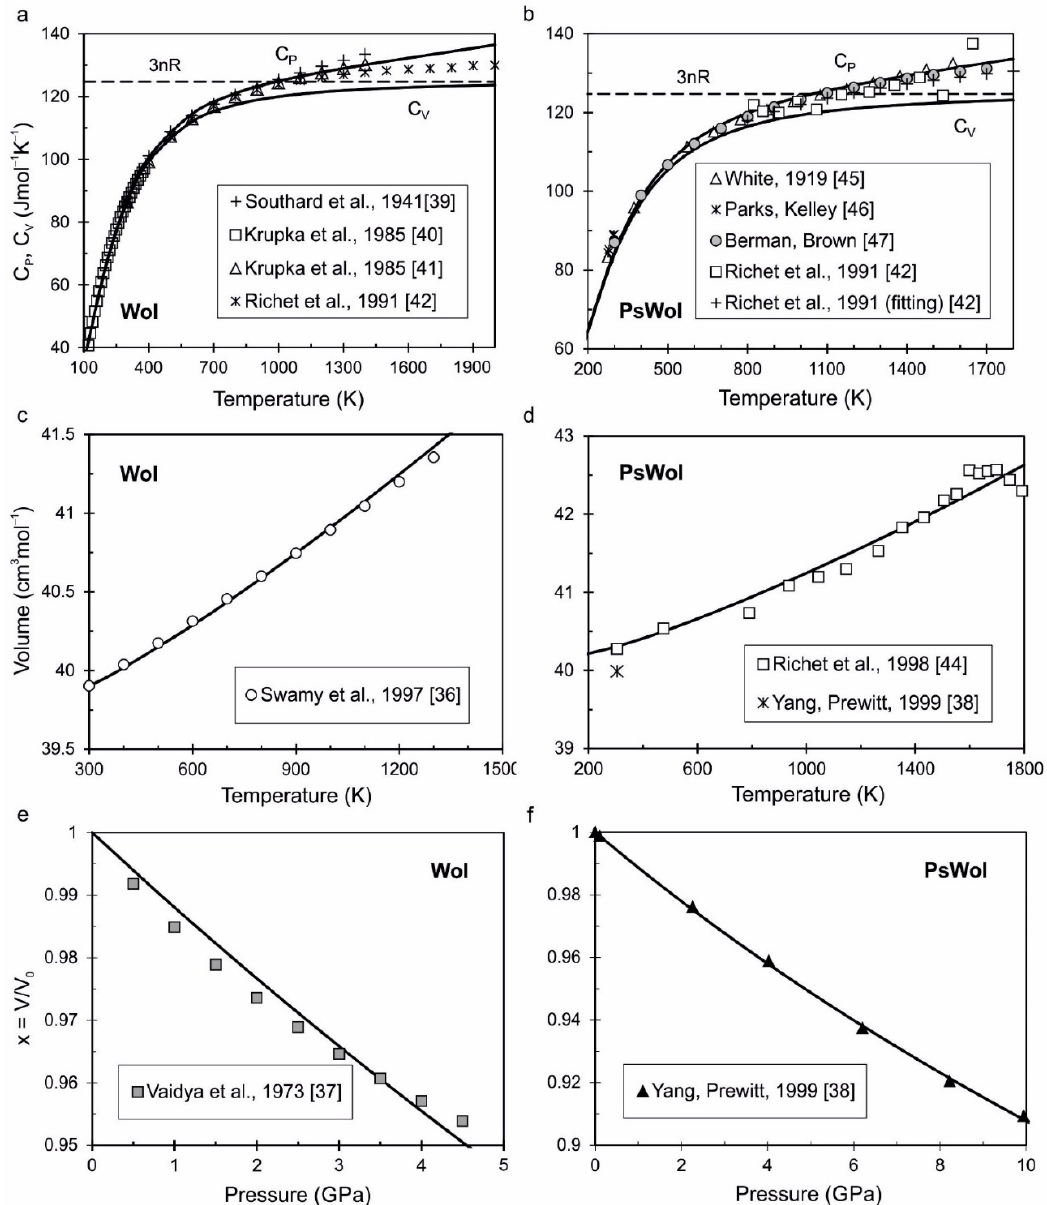
Figure 1. The calculated heat capacity ( a , b ), molar volume at reference pressure ( c , d ) and compressibility as a function of pressure ( e , f ) of wollastonite (Wol) and pseudowollastonite (PsWol) in comparison with different reference and experimental data from [36,37,39–42] for Wol and from [38,42,44–47] for PsWol. Table 2. Thermodynamic functions of wollastonite at different pressures and temperatures.